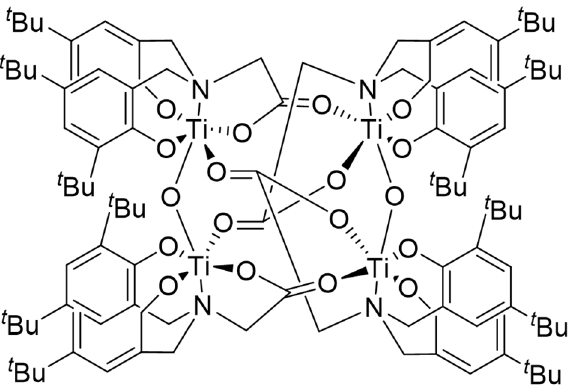
Figure 3. Tetrametallic Ti cluster 4 .